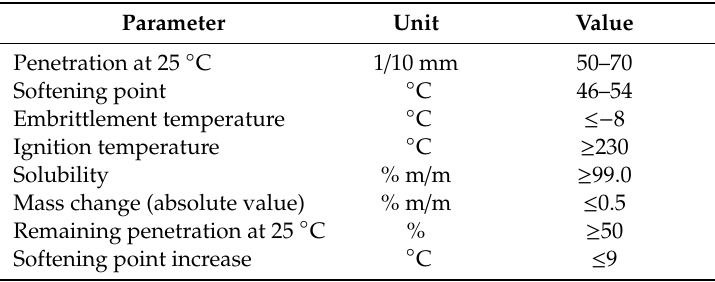
Table 2. Parameters of road asphalt 50 / 70